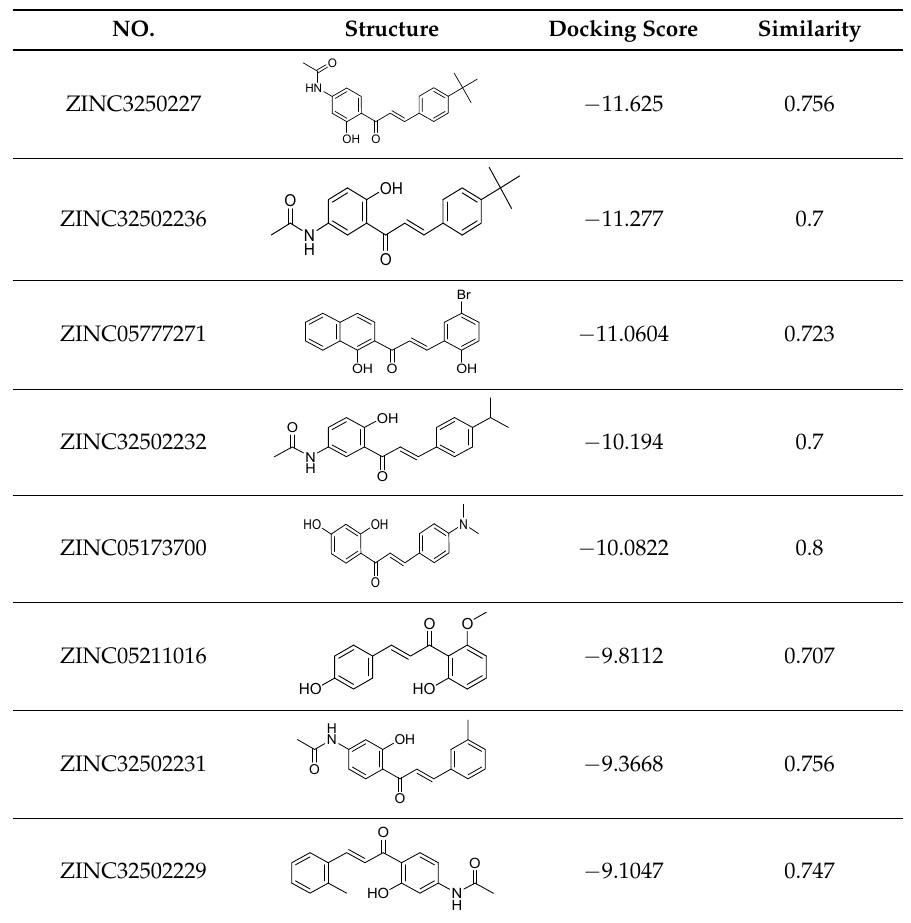
( b ) Figure 2. Comparison between the binding mode of ZINC08665430 ( a ) and compound 36 ( b ) in the LXR β active site. Table 5. Chemical structures of newly-screened ABCA1 up-regulator targeting LXR β . NO.